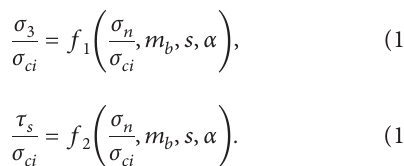
Figure 4: Design recommendations for pseudostatic analysis